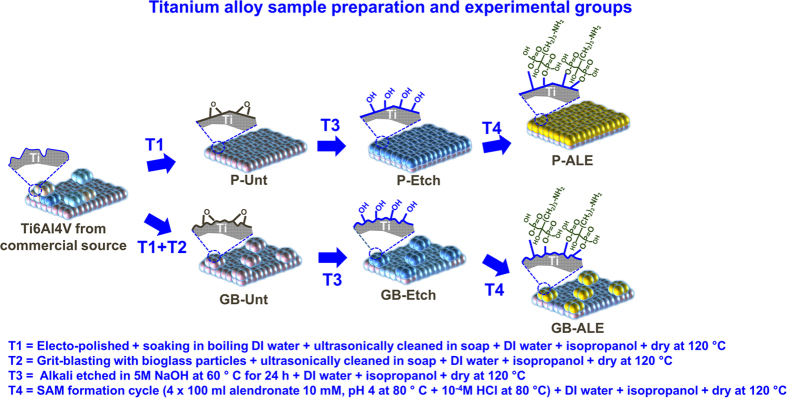
Schematic representation of the fabrication process for alendronate SAMs onto TiAl6V4 alloy indicating sample treatments and resulting surfaces electro-polished (P-Unt), electro-polished alkali etched (P-Etch), electro-polished alendronate SAM (P-ALE), grit-blasted (GB-Unt), grit-blasted alkali etched (GB-Etch) and grit-blasted alkali etched alendronate SAM (GB-ALE).